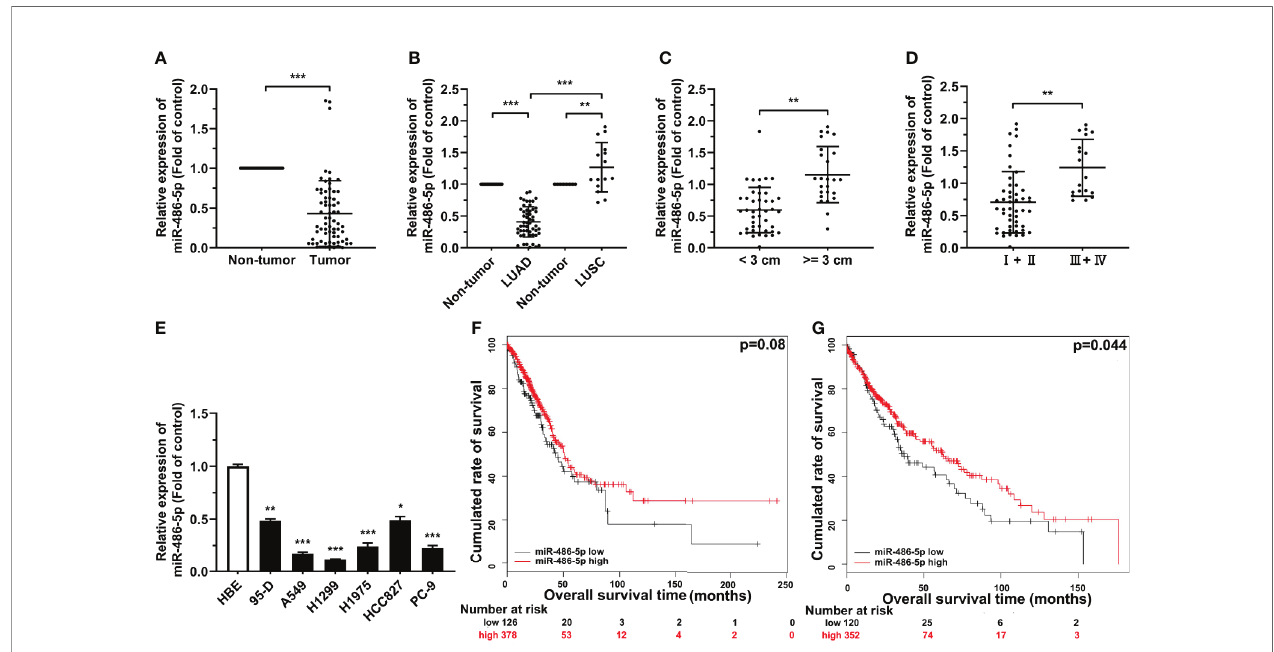
FIGURE 1 | miR-486-5p is downregulated in NSCLC and correlated with patients ’ longer survival. (A) The expression of miR-486-5p in 68 pairs of NSCLC specimens relative to their adjacent normal tissues. ***p < 0.001. (B) The miR-486-5p expression in the LUAD (N=53) and LUSC (N=15) tissue samples. **p < 0.01; ***p < 0.001. (C) miR-486-5p expression in tissue samples with diameters < 3 cm (N=43) and >= 3 cm (N=25). **p < 0.01. (D) miR-486-5p expression in TNM stage I and stage II (N=49) NSCLC tissues and stage III and stage IV (N=19) tissues. **p < 0.01. (E) The expression of miR-486-5p in NSCLC cell lines 95-D, A549, H1299, H1975, HCC827 and PC-9. HBE cells were used as normal control. *p < 0.05; **p < 0.01; ***p < 0.001. (F, G) Retrospective analysis of Kaplan-Meier plots for miR-486-5p expression in association with overall survival of LUAD (F) and LUSC (G)